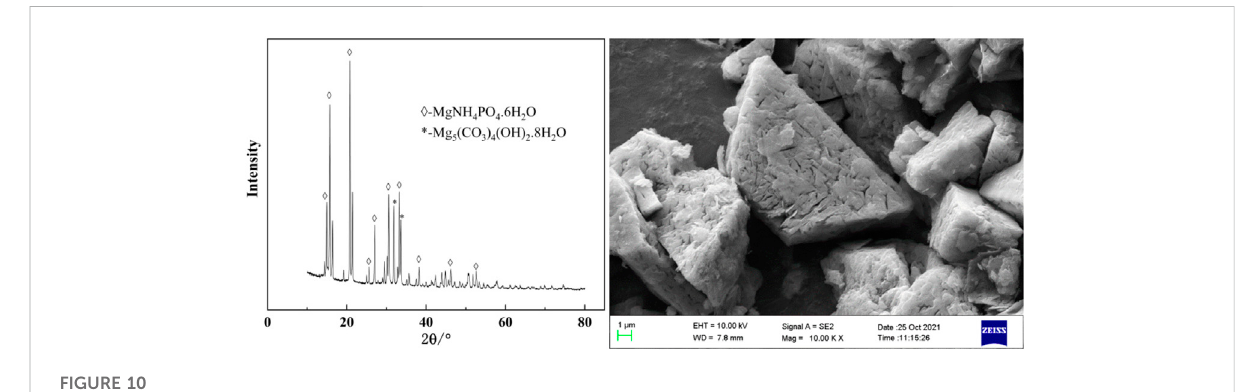
FIGURE 10 XRD and SEM of the